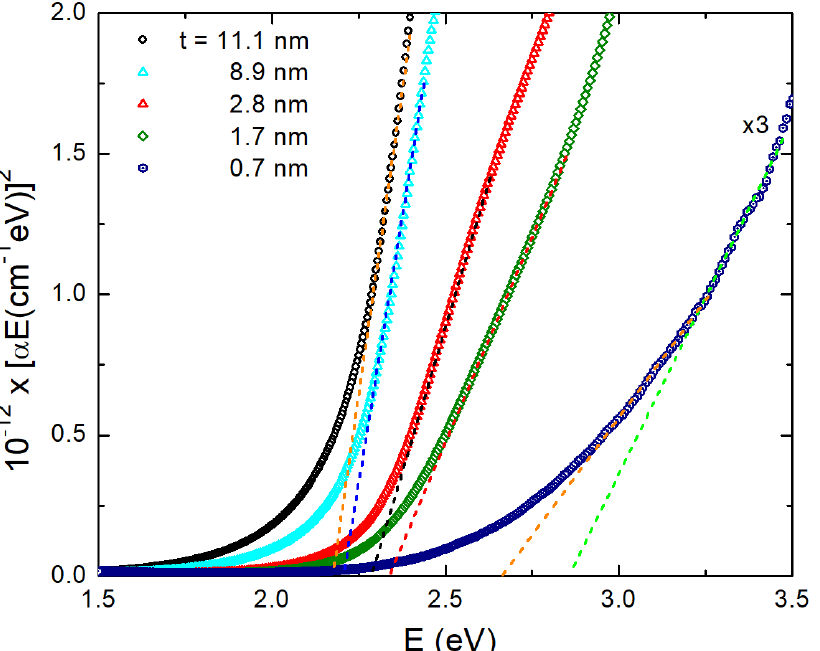
Figure 4. Tauc plots (( α E ) 2 as a function of E) for five PdO films; their thickness t is indicated in the legend. One can clearly observe a “blue” shift of the energy gap as t